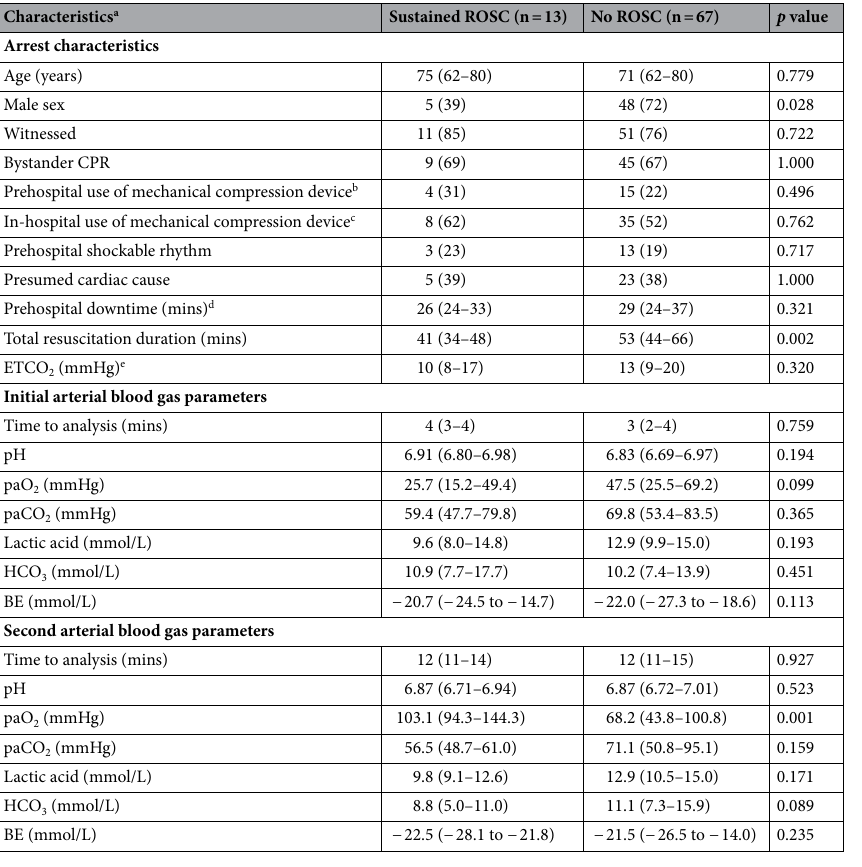
Table 1. Baseline characteristics of included patients and arterial blood gas parameters obtained during cardio-pulmonary resuscitation (CPR). BE base excess, ETCO 2 end-tidal carbon dioxide, HCO 3 bicarbonate, paO 2 partial pressure of arterial oxygen, paCO 2 partial pressure of arterial carbon dioxide, ROSC return of spontaneous circulation. a Continuous variables are expressed as median with interquartile ranges; categorical values are expressed as a number with a percentage. b LUCAS ® , Lund University Cardiopulmonary Assist System; Physio-Control Inc./Jolife AB, Lund, Sweden or AutoPulse ® ; Zoll Medical Corporation, Chelmsford, MA, USA. c LUCAS ® . d Defined as the estimated time from the first recognition of a sign of cardiac arrest to arrive in the hospital. The downtime in unwitnessed cases would be longer than the estimation. e The level of ETCO 2 was measured at 10 min after ED arrival of the